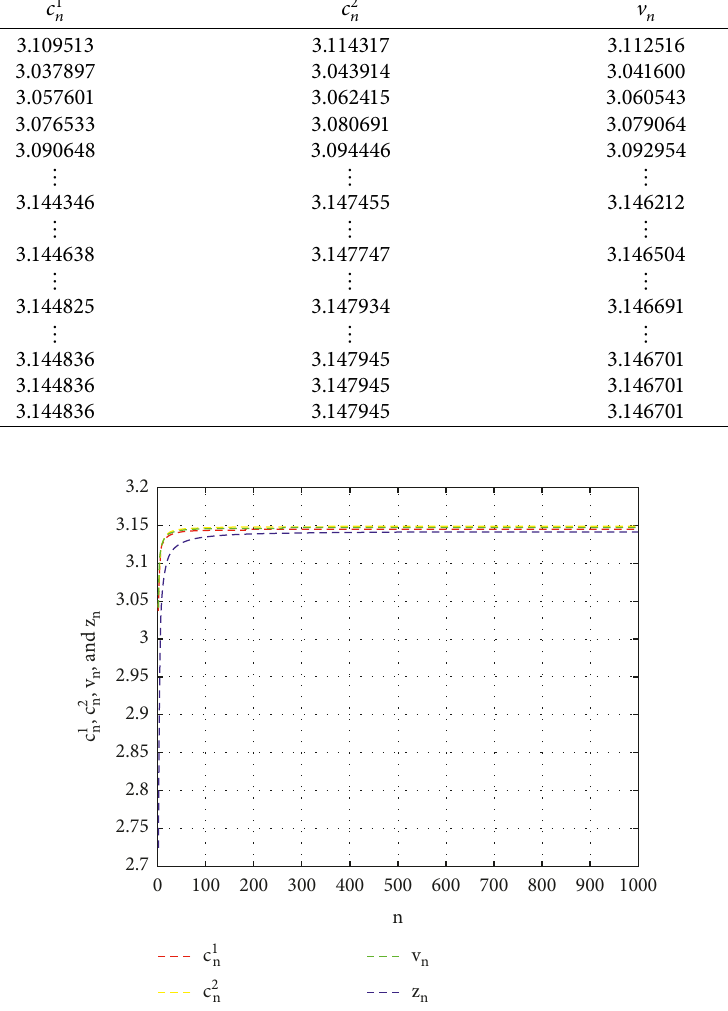
Figure 2: The comparison of sequences c 1